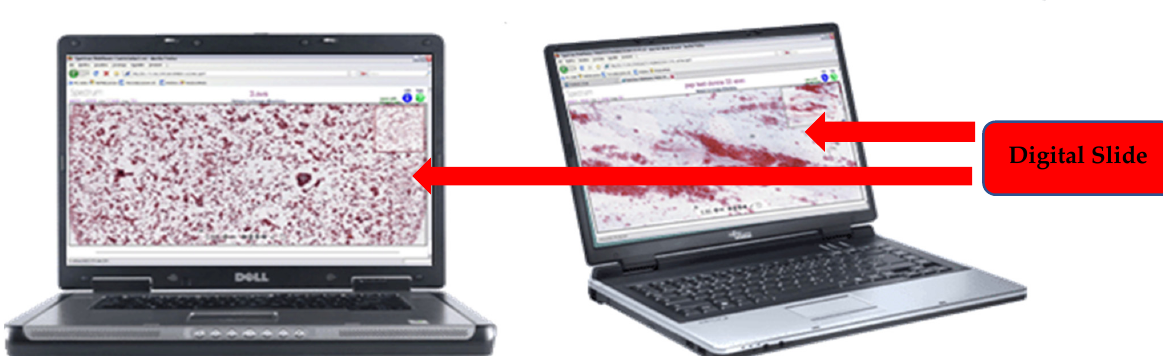
Figure 1. Access to the digital slides using eHealth.